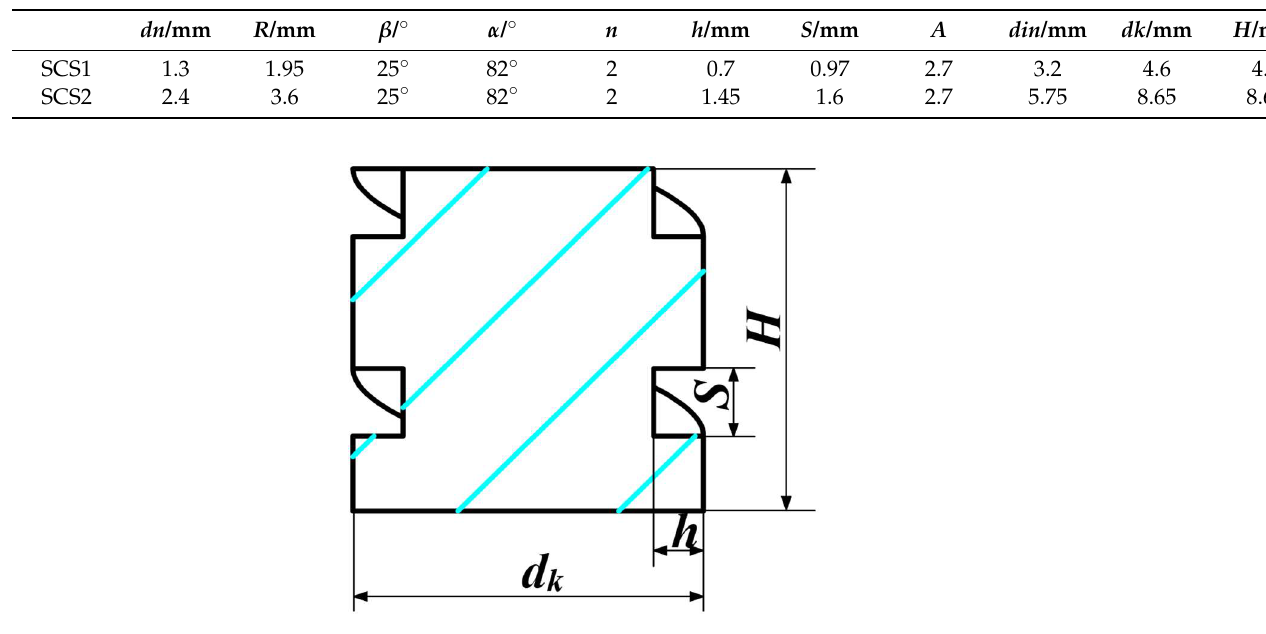
Figure 4. Screw-conveyor swirler structure parameter characterization chart. Table 3. Theoretical calculation value for each experimental condition.